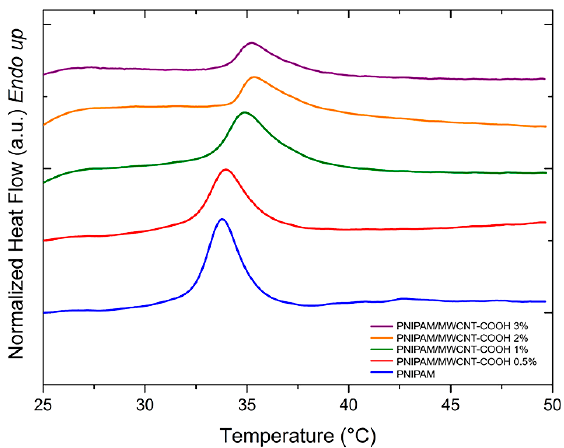
Figure 8. DSC curves (heating rate 10 °C/min) for determination of volume phase transition peak of PNIPAM/MWCNT-COOH hydrogels at different filler concentrations hydrated in PBS solution.